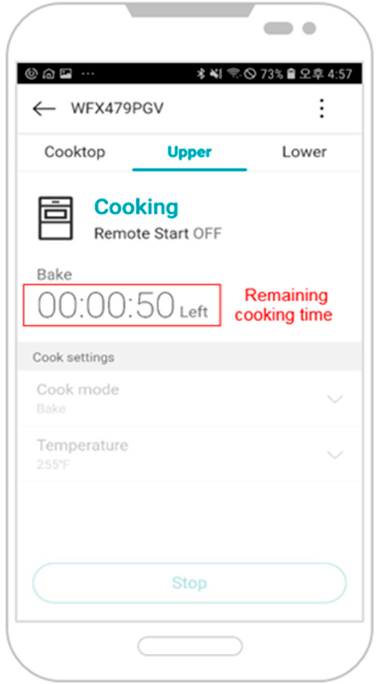
Figure 10. Screenshot of smartphone application the displaying remaining cooking time of the smart oven.